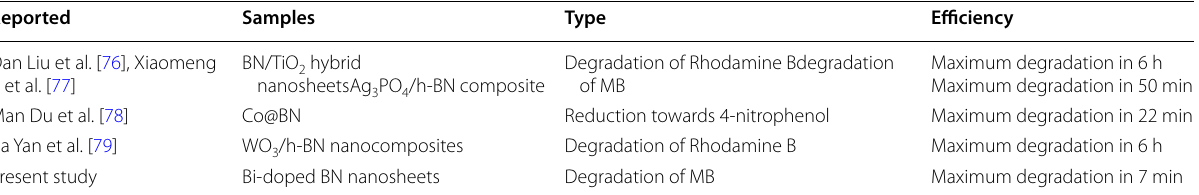
Table 1 Comparison of dye degradation with respect to reported literature